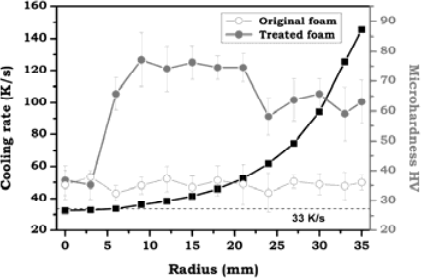
Figure 14. Simulated cooling rates in the critical range ( ■ ) at z = 0, as a function of the radius. Microhardness profiles in the central section ( z = 0) of the, treated ( ● ) and untreated ( ○ ) 70/70 mm